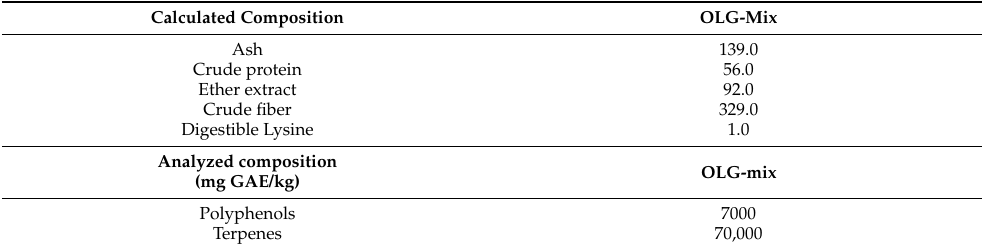
Table 1. Calculated composition and analysis of olive and grape-based by-product (OLG-mix) (g/kg as fed basis, unless otherwise